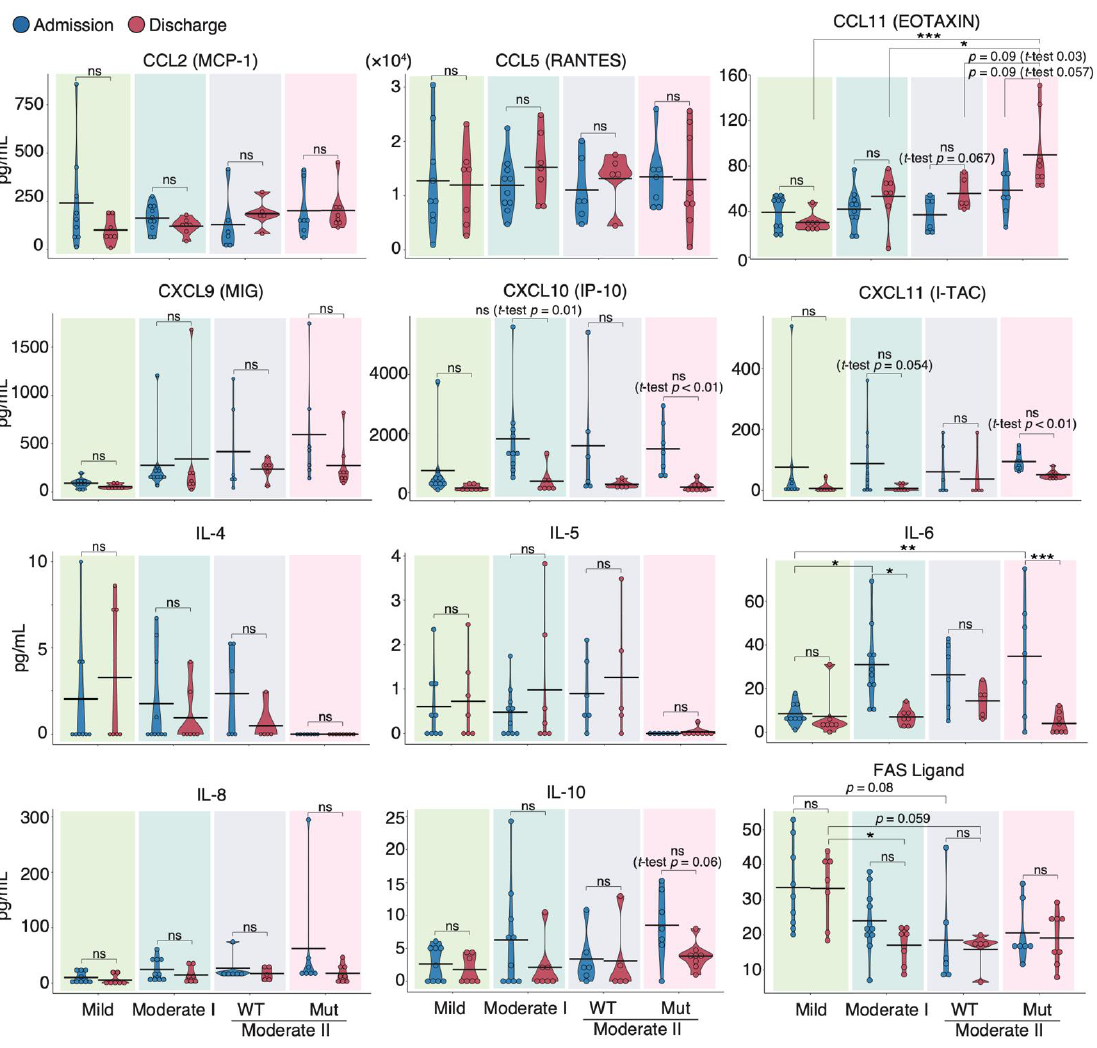
Figure 2. Serum cytokine features of COVID-19 patients infected with the WT strain and VOCs. Graphs show representative cytokine concentrations for each severity ( n = 9 patients/mild group; 10 patients/moderate I group; 9 patients/WT-infected moderate II group; 8 patients/VOC-infected moderate II group). Blue and red dots indicate admission and discharge, respectively. Statistical significances were determined using the Tukey – Kramer test and Welch ’ s t -test. * p < 0.05; ** p < 0.01; *** p < 0.005; ns, not significant. Next, we compared serum cytokine levels upon admission between the WT and VOC-infected patient groups (Supplementary Materials; Figure S4). The time from onset of symptoms to blood collection was similar (WT 8.3 ± 4.1 d, VOCs 8.0 ± 2.8 d). We found that the serum levels of IFN- α, IL -13, IL-10, and CCL11 were higher in VOC-infected patients than in WT-infected individuals, whereas IL-5 and IL-4 were higher in WT- infected patients than in those with VOCs. These data suggest that different immune responses occurred during infection with mutant and WT strains.